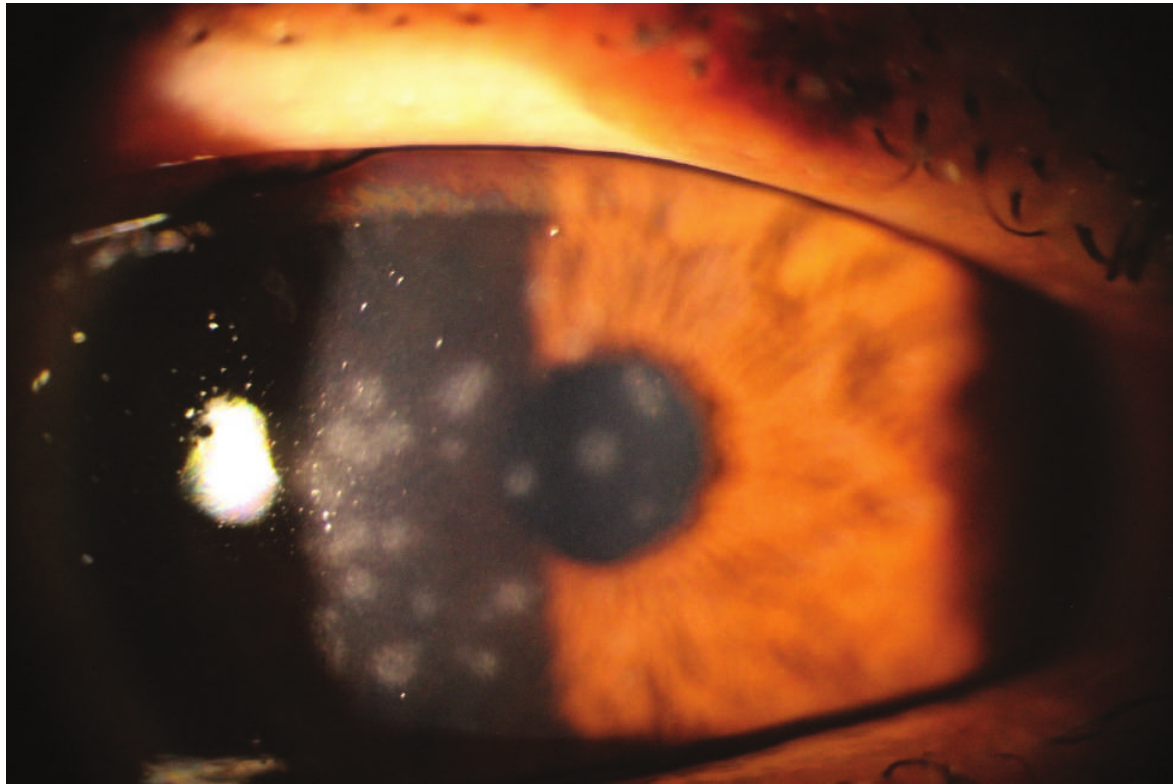
Figure 3. Subepithelial infiltrations in a patient with adenoviral